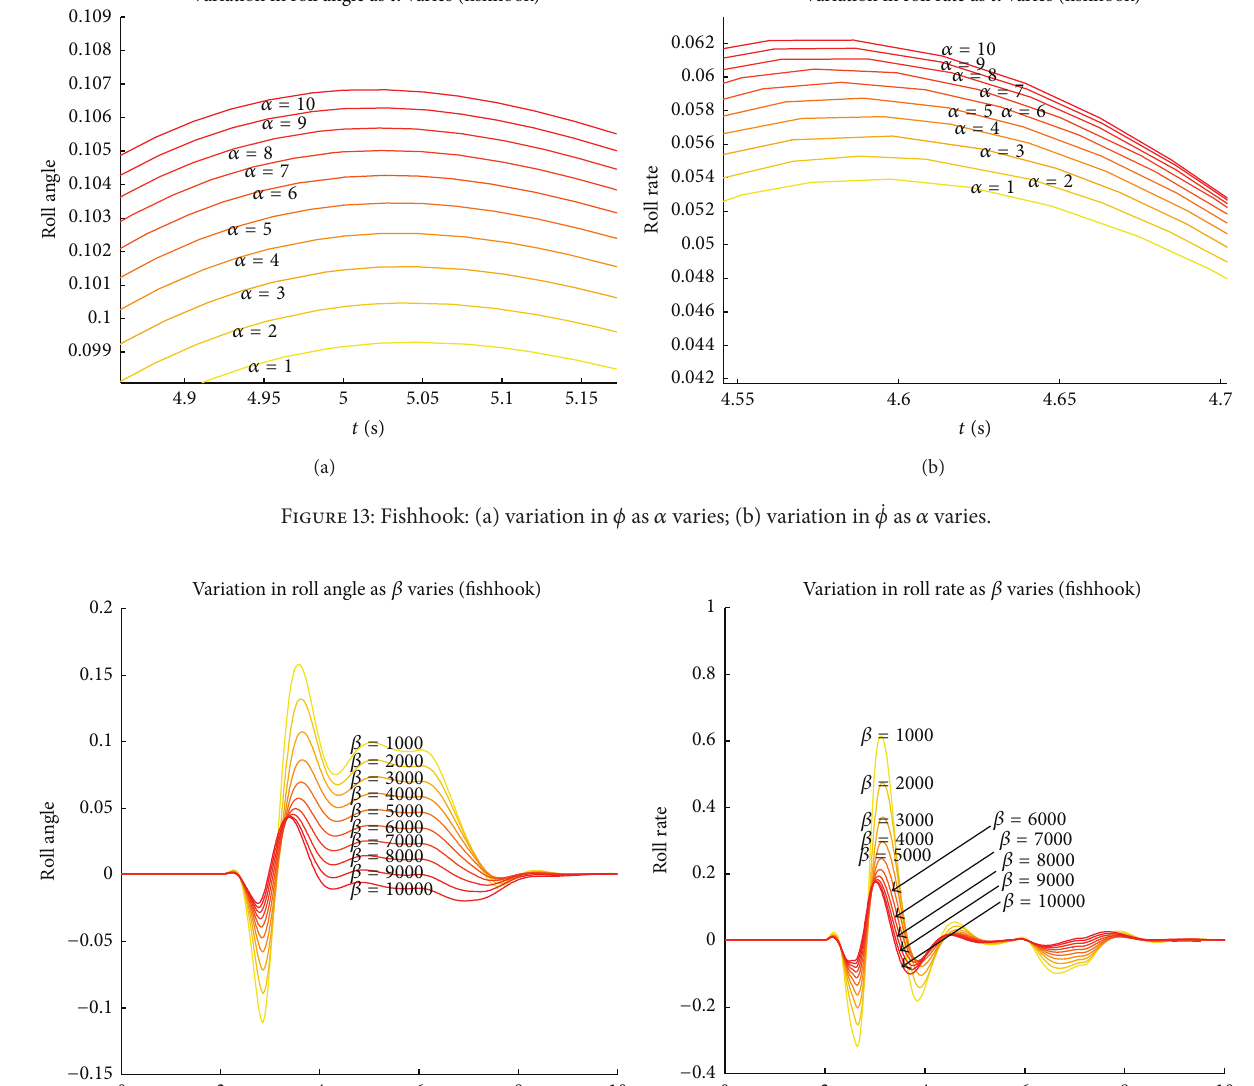
Figure 14: Fishhook: (a) variation in 𝜙 as 𝛽 varies; (b) variation in